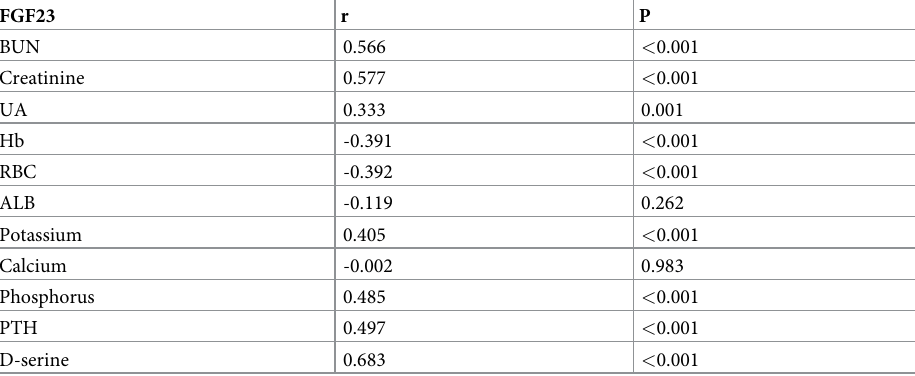
Table 3. Analysis of factors associated with